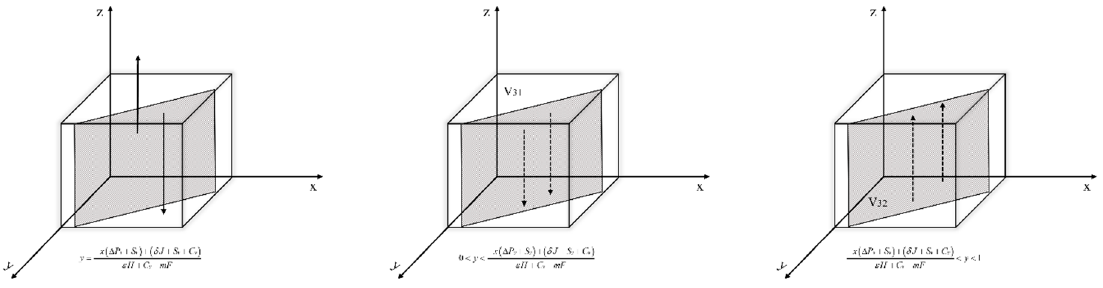
Figure 7. Dynamic evolution of financial institutions decision-making.